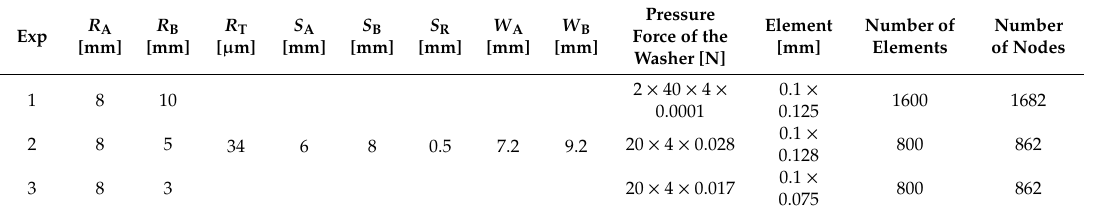
Table 1. Dimensions of the FeCoB samples ( R A , R B , R T ), of the micrometric screw ( S A , S B , S R ), of the pressure washer ( W A , W B ), and the parameters for modelling of tensile stress in the surface